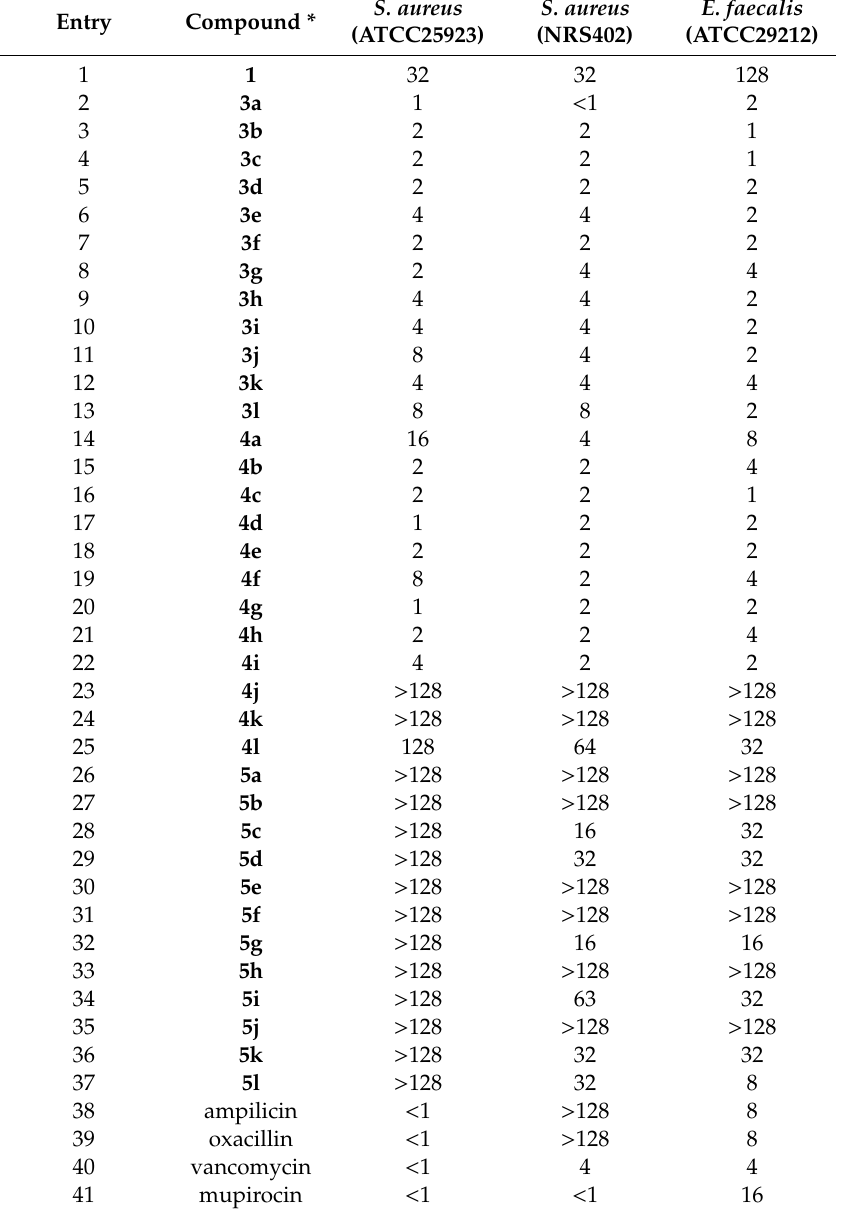
Table 5. Minimum inhibitory concentration (MIC) for compounds 1 , 3a – l , 4a – l , and 5a – l against the three selected Gram-positive bacterial